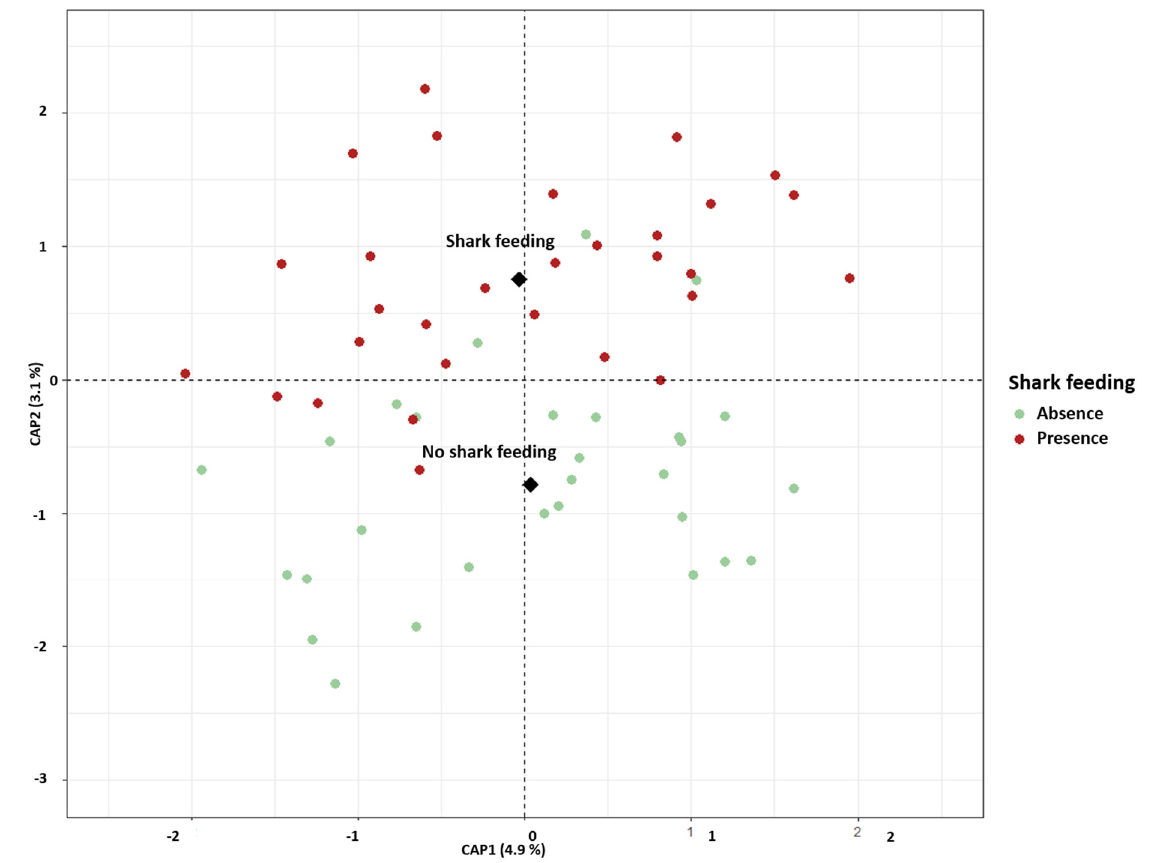
Figure 4. Microbial communities of BRS gut, as illustrated by a db-RDA using Bray–Curtis dissimi- larities (best model: number of reads + shark provisioning). Shark provisioning being factorial, it is represented by its centroid (black diamonds).